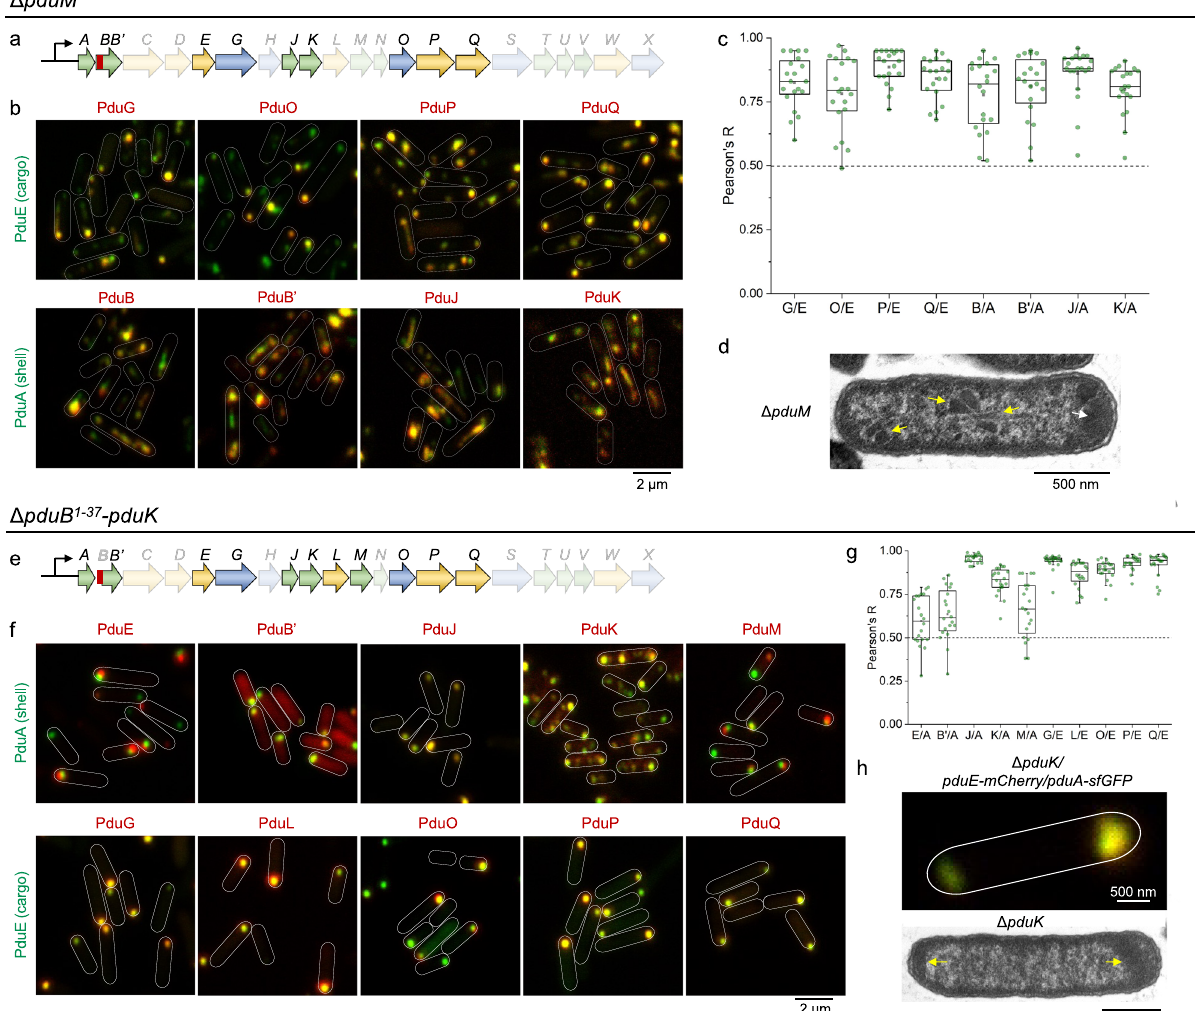
Fig. 4 Roles of PduM and PduK in the biogenesis of Pdu BMCs. a Relevant genes encoding shell and catalytic proteins of relevance to ( b , c ), highlighted in the context of the pdu operon of S . Typhimurium LT2. b PduE-sfGFP (green) and mCherry-fused catalytic components (red), and PduA-sfGFP (green) and mCherry-fused structural components (red) were visualized in Δ pduM grown in MIM + 1,2-PD media. c Colocalization analysis of sfGFP and mCherry fl uorescence in ( b ). The graph is labeled as described in the legend to Fig. 3. The Pearson ’ s R values for all the strains are: 0.83 ± 0.10 (G/E); 0.78 ± 0.14 (O/E); 0.89 ± 0.07 (P/E); 0.84 ± 0.08 (Q/E); 0.78 ± 0.13 (B/A); 0.81 ± 0.12 (B ′ /A); 0.86 ± 0.10 (J/A); 0.80 ± 0.09 (K/A). d EM of the Δ pduM strain, showing a polar enzymatic core (white arrow) and various shapes of the shell structure (yellow arrows). e Related shell and catalytic genes in f , g were highlighted in the pdu operon. f PduA-sfGFP (green) and mCherry (red, labeling PduE and different structural components), and PduE-sfGFP (green) and mCherry (red, labeling different catalytic components), were visualized in Δ pduB 1 – 37 - Δ pduK strain growth in MIM + 1,2-PD media. g Colocalization analysis of sfGFP and mCherry fl uorescence in ( f ). The Pearson ’ s R values for all the strains are: 0.60 ± 0.14 (E/A); 0.63 ± 0.15 (B ′ /A); 0.96 ± 0.02 (J/A); 0.83 ± 0.08 (K/A); 0.66 ± 0.16 (M/A); 0.94 ± 0.05 (G/E); 0.86 ± 0.07 (L/E); 0.89 ± 0.05 (O/E); 0.93 ± 0.04 (P/E); 0.92 ± 0.07 (Q/E). h The polar aggregates of Pdu proteins were visualized in confocal microscopy (top) and EM (bottom, yellow arrows) of the Δ pduK strain. Note: In ( c , g ), data are represented as mean ± SD. n = 20, n represents the number of cells. Boxplot center lines correspond to the median value, and upper and lower whiskers extend from the box to the largest or smallest value correspondingly, but no more than 1.5 times the interquartile range; mean values show as the square